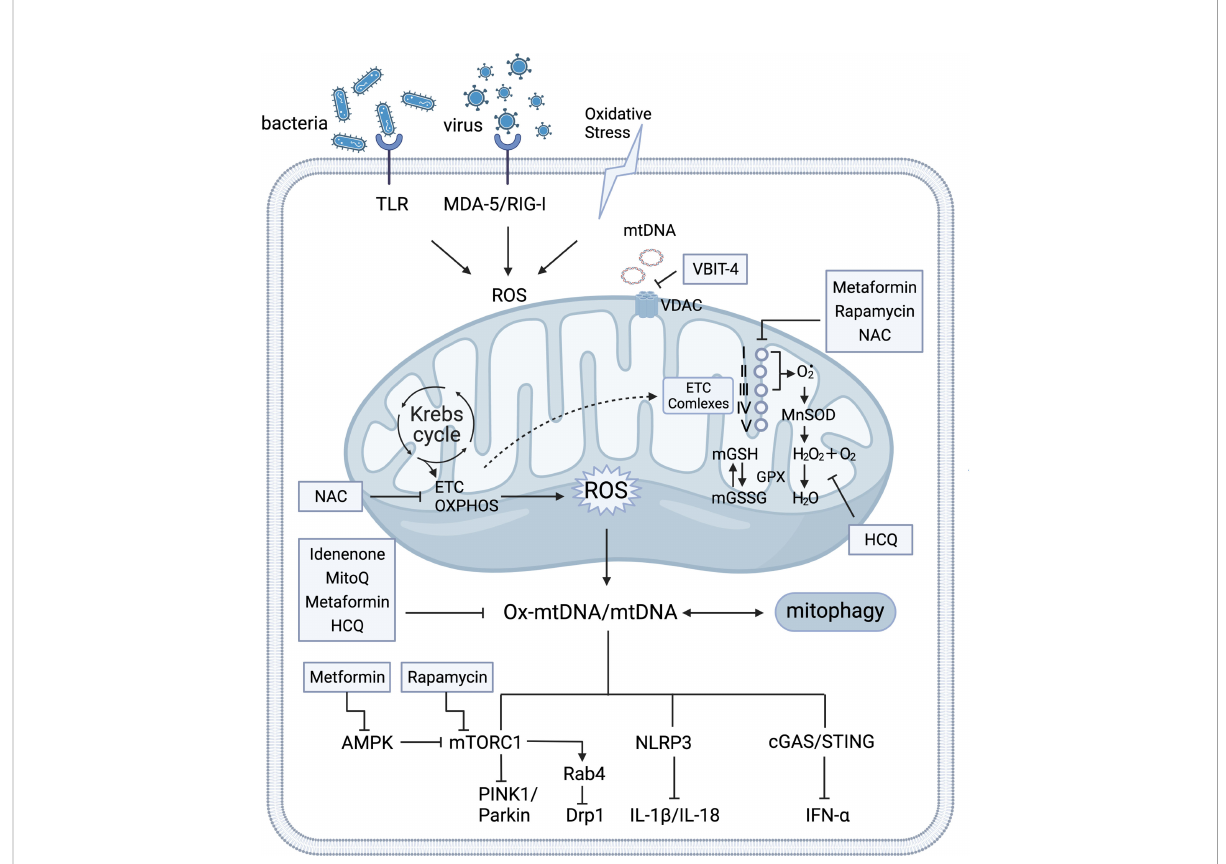
FIGURE 1 Crosstalk of mitochondria homeostasis and immune signaling. Mitochondria support the major generation of reactive oxygen species(mROS) for modulating various signaling and cellular metabolism. Mitochondria produce ATP through the tricarboxylic acid cycle (TCA) oxidative phosphorylation (OXPHOS) at electron transport chain (ETC) complexes. Detoxify free radicals from ETC complexes reduced by manganese superoxide dismutase (MnSOD) and glutathione peroxidase (GPX) into water (H 2 O). GPX, as a catalase, also regulates the conversion balance of oxidized glutathione (GSH) and glutathione disul fi de (GSSG) in mitochondria. Under the circumstance of oxidative stress that is stimulated by insults and exogenous pathogens, various DNA sensors trigger aberrant mitochondrial function by activation of pattern recognition receptors in the cytosol and mitochondria (e.g. retinoic-acid-inducible protein I (RIG-I), melanoma differentiation-associated protein 5 (MDA-5), and Toll-like receptor(TLR)). Expulsion of highly immunogenic Ox-mtDNA out of mitochondria stimulates AMP-activated protein kinase (AMPK), mammalian target of rapamycin complex 1 (mTORC1), Nucleotide-binding oligomerization domain (NOD)-like receptor pyrin domain-containing protein 3 (NLRP3)-mediated IL-1 b and IL-18 production, and cyclic GMP-AMP (cGAS) and the cyclic GMP-AMP receptor stimulator of interferon genes (STING)-dependent IFN- a . Under conditions of nutrient deprivation, AMPK inhibits energy-consuming pathways by mTORC1 for mitophagy activation. The HRES-1/Rab4-mediated dynamin-related protein 1 (Drp1) depletion reverses mitochondrial accumulation via mTOR-independent pathway. Mitochondrial respiration (ETC), mTORC1, and cGAS-STING signaling pathway serve as potential therapy targets. Several medications that targeting mitochondria metabolism process has been observed the therapeutic clinical effectiveness in SLE, including N-acetylcysteine (NAC), Rapamycin, Metformin, Mito Q, Hydroxychloroquine (HCQ), and Idenenone. The voltage-dependent anion selective channel (VDAC) oligomer inhibitor VBIT 4 can inhibit the release of mtDNA. I, II, III, IV, and V represent the electron transport chain complexes I – V. Glutathione reductase